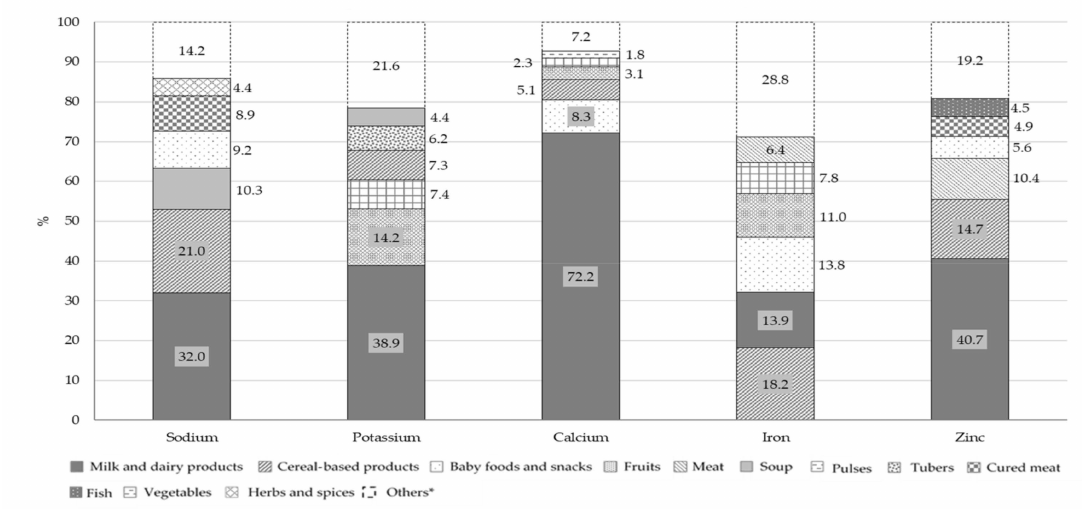
Figure 5. Percentage contribution of selected food groups to total intake of minerals ( n = 389). * For each variable, the category “Others” includes all the food groups not considered